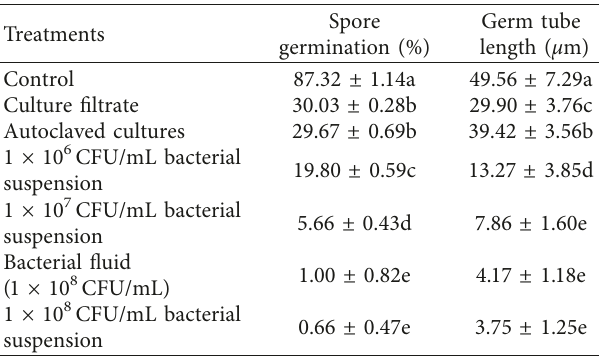
Table 2: The effect of P. fluorescens on spore germination and germ tube elongation of P. digitatum